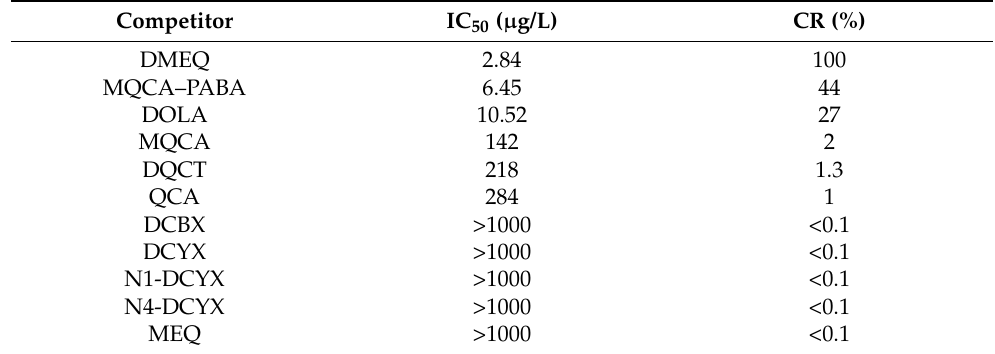
Table 2. The cross-reactivity of mAb to different analytes.